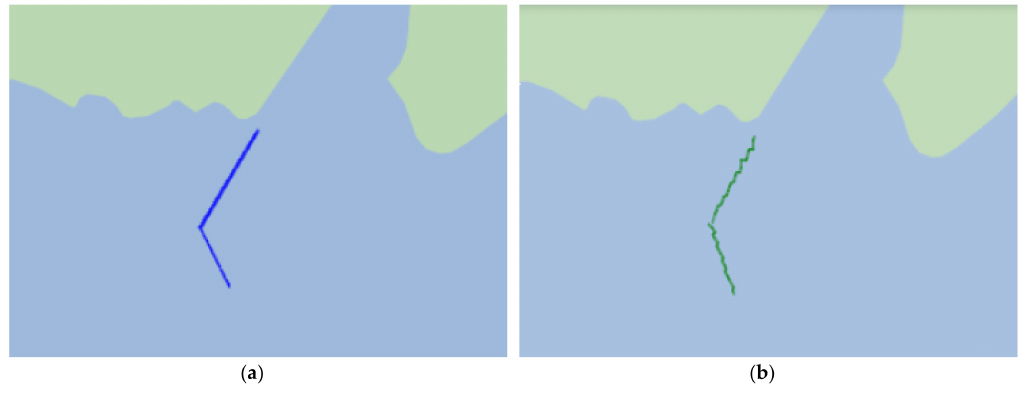
Figure 8. Trajectory of real motion. ( a ) Actual trajectory; ( b ) Estimated trajectory.